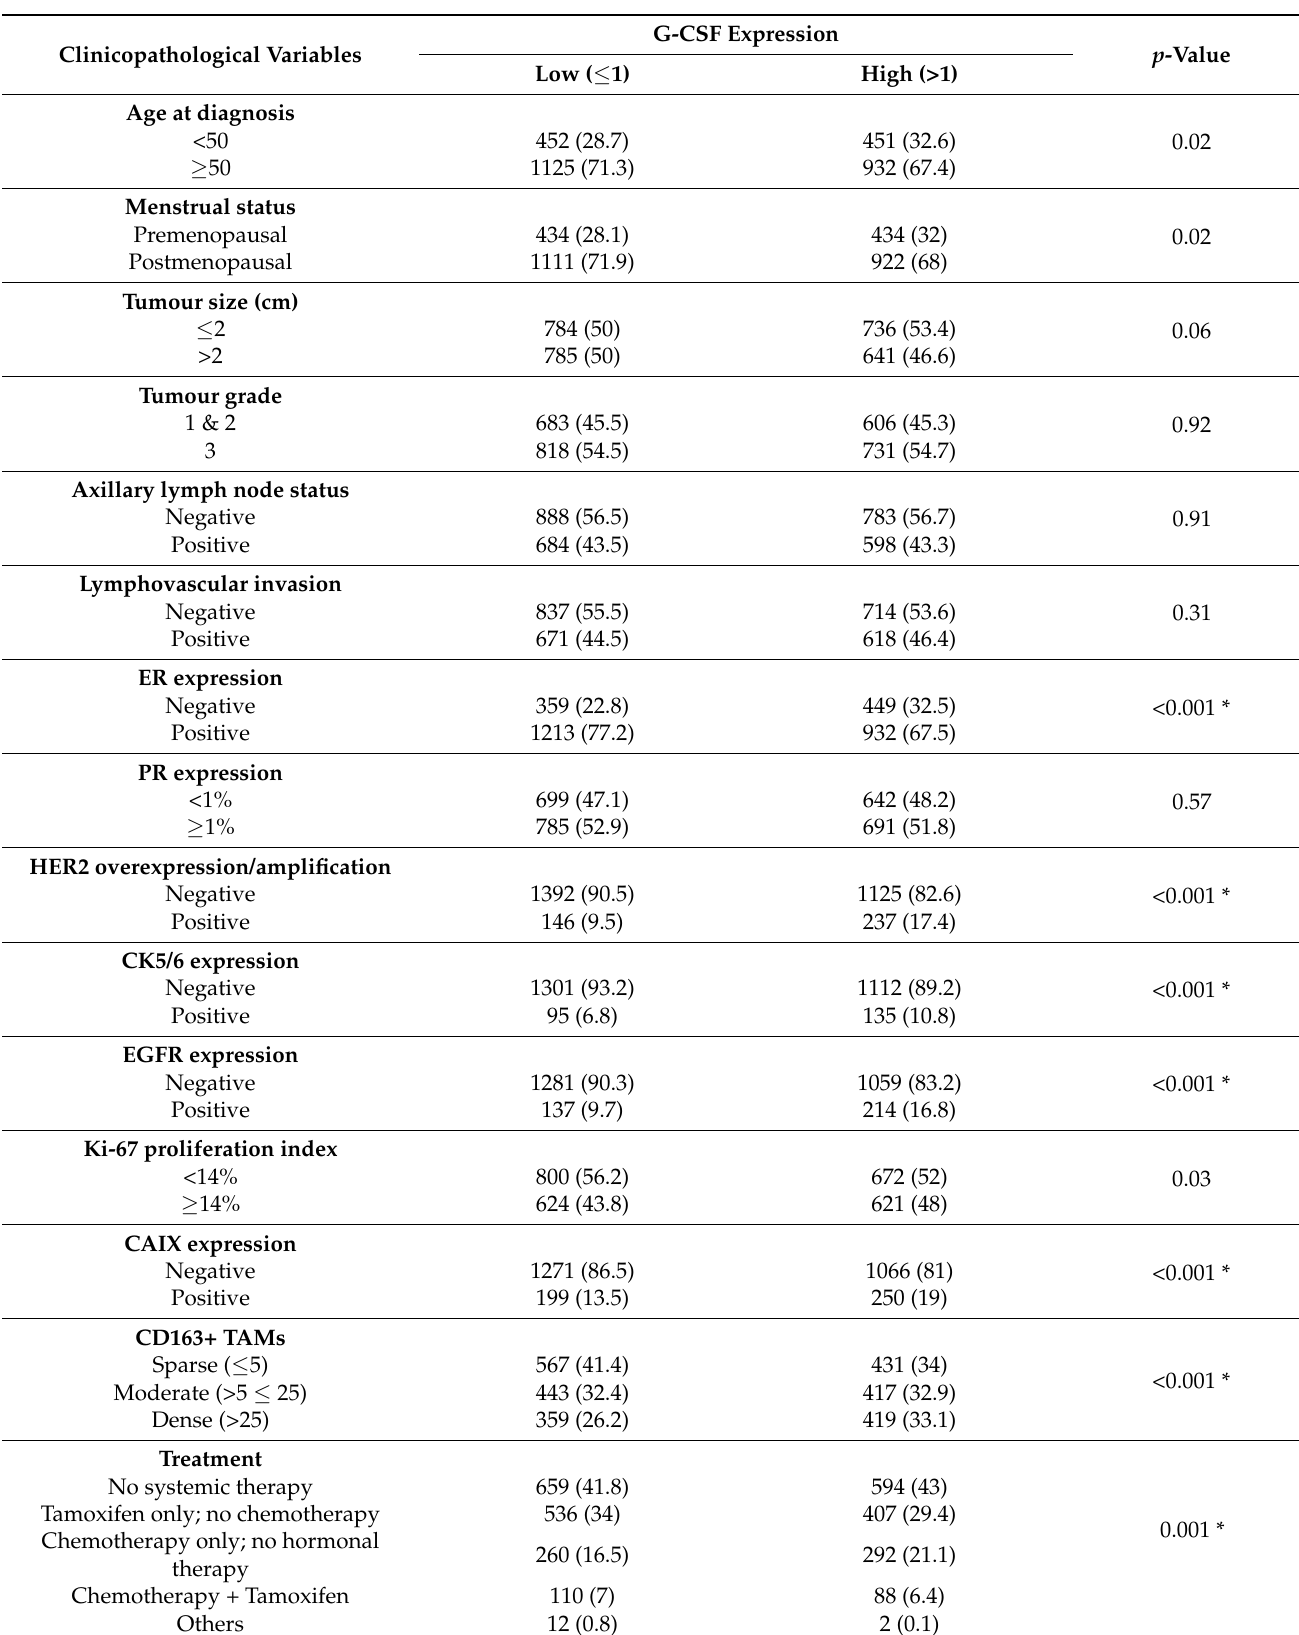
Table 1. Correlation of G-CSF expression with clinicopathological features and other